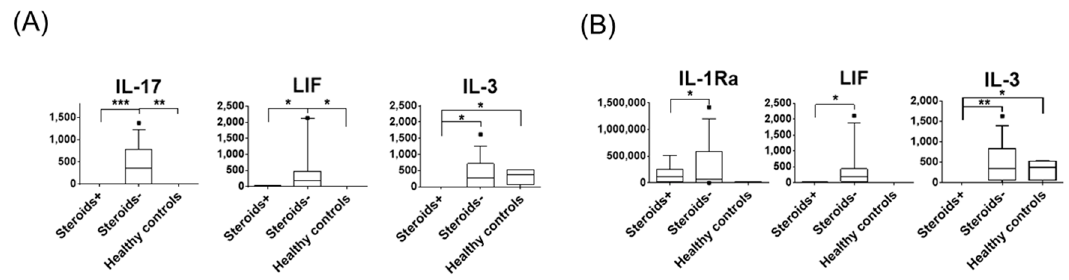
Figure 4. Effects of corticosteroids on baseline cytokine expression. Baseline tear protein expression was compared between transplant eyes ( A ) and contralateral eyes ( B ) with topical corticosteroids, without corticosteroids, and in age-matched controls. Corticosteroids + : n = 6, corticosteroids − : n = 15, and age-matched controls: n = 4. The proteins presenting significant differences between the corticosteroids + and corticosteroids − groups are shown. The median, 10%, 25%, 75%, and 90% percentiles are shown. pg/mL. * p < 0.05, ** p < 0.02, *** p < 0.01.